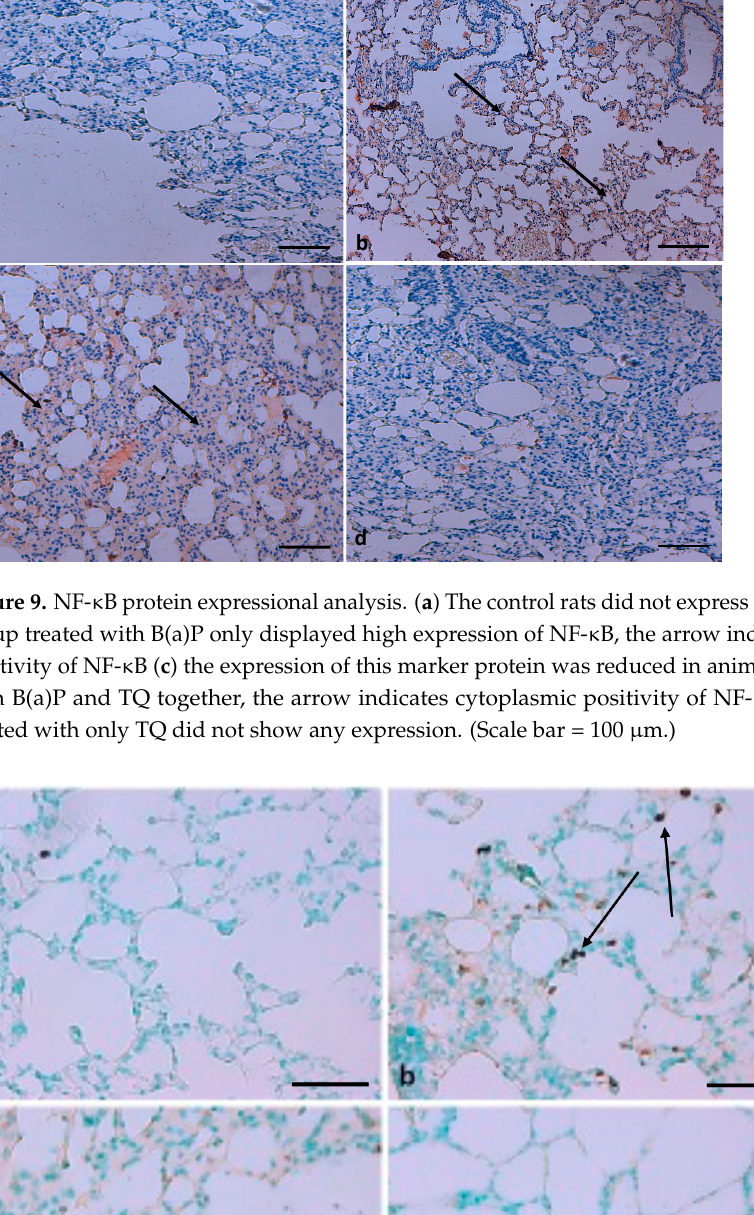
7 of 16 Figure 8. Effect of TQ on lung fibrosis. ( a ) Normal fibre architecture of hepatocyte in control ani- mals; ( b ) B(a)P administration induces severe fiber deposition; the arrow indicates deposition of fibers ( c ) TQ shows suppression of B(a)P-induced fibrosis, the arrow indicates less deposition of fibers and ( d ) normal fibre architecture observed in the group treated with TQ only. (Scale bar = 100 μ m.) 3. TQ Reduces NF- κ B Expression in Lung Tissue